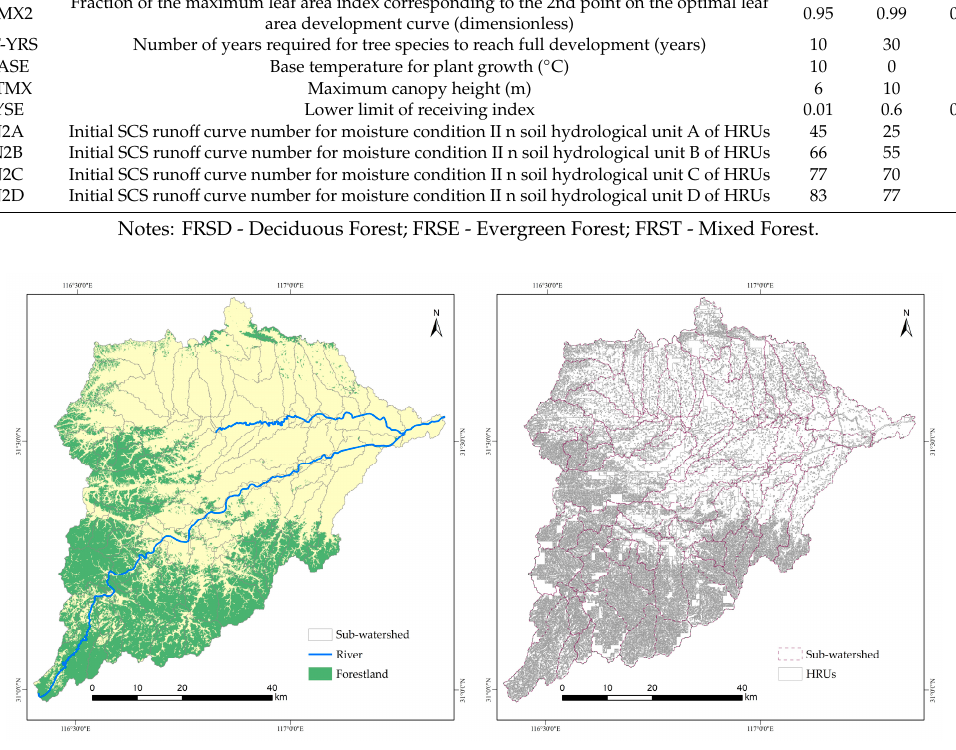
Figure 2. The distribution of sub ‐ watersheds and HRUs.